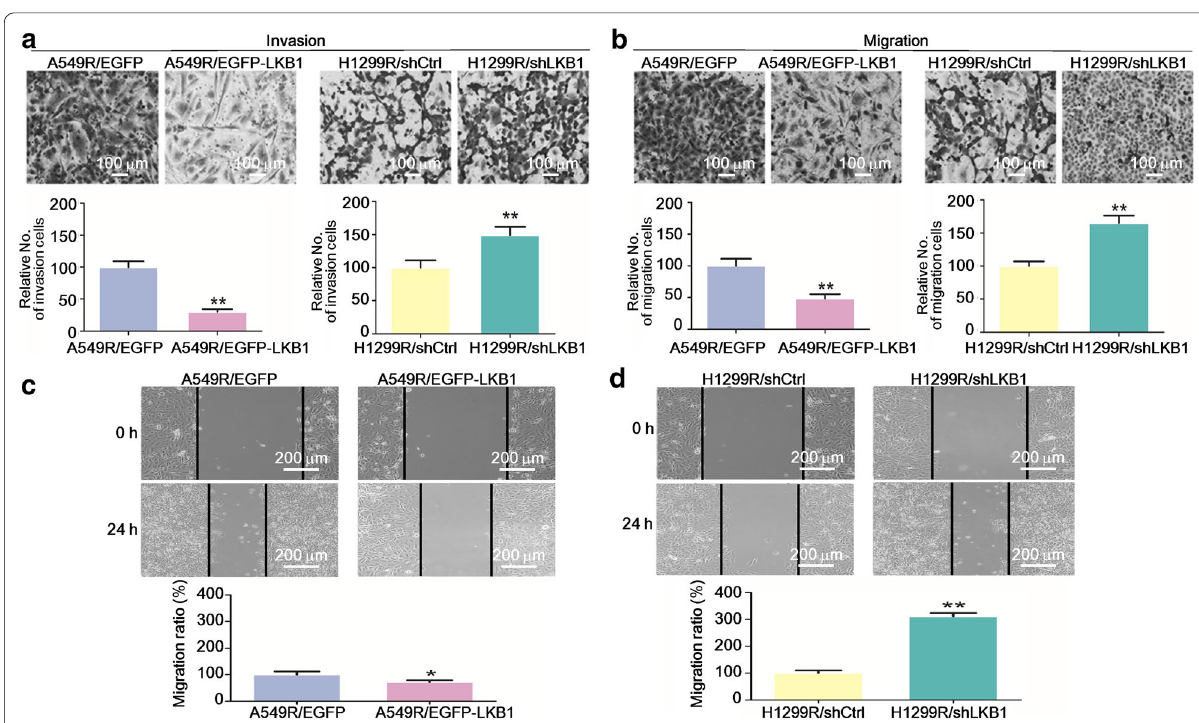
Fig. 5 LKB1 suppressed the invasion and migration of A549R and H1299R cells. a , b Transwell matrigel invasion and migration assays with A549R cells transfected with EGFP or EGFP‑LKB1, and H1299R cells transfected with shCtrl or shLKB1. c , d Wound healing assay with A549R cells transfected with EGFP or EGFP‑LKB1, and H1299R cells transfected with shCtrl or shLKB1. The experimental procedure is described in Fig. 3, * P < 0.05; ** P < 0.01 (Student’s t